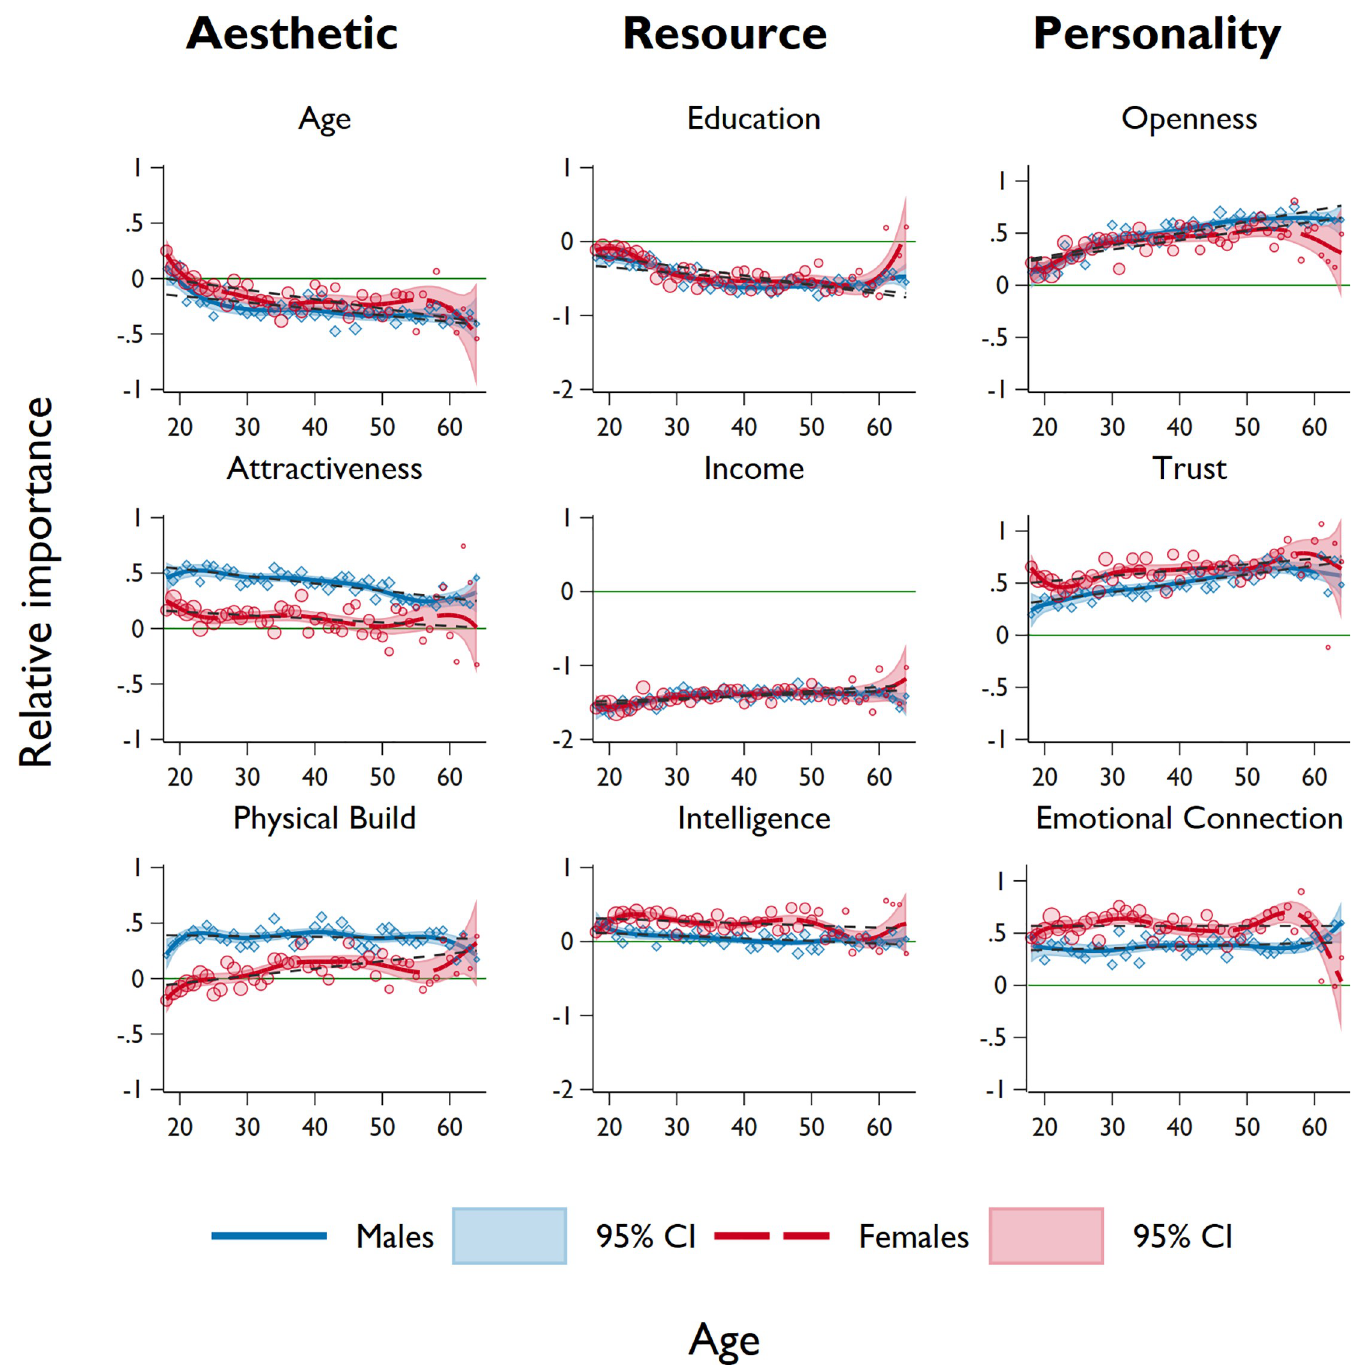
Fig 2. Level of sexual attraction for aesthetic, resource, and personality characteristics over age, by sex. Markers represent the average relative importance for each characteristic within sex (males = blue, females = red), calculated at each year of age. Smoothed lines represent the local cubic polynomial with Gaussian kernel function and bandwidth of 5, with shaded areas representing the 95% confidence intervals. We also show the linear fit of the observations across age, represented in grey dashed lines. The green reference line (relative importance = 0) indicates a factor is of the same importance to the average of all nine characteristics. Each characteristic is graphed for participants aged 18–64